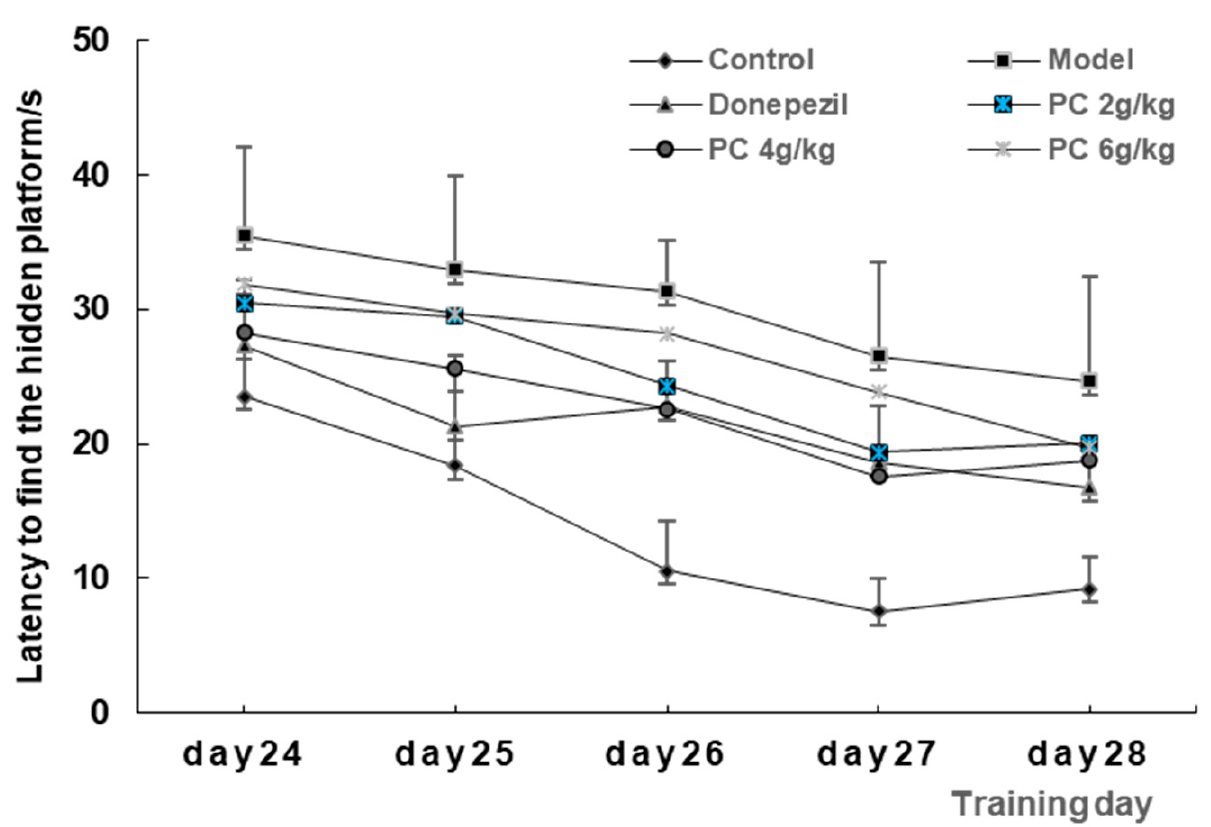
Figure 3. The latencies of mice in the acquisition trials of MWM. A total of 60 mice were randomly divided into six groups of 10 animals each, the control (0.5% CMC-Na solution, 0.2 ml/10 g), the model (0.5% CMC-Na solution, 0.2 mL/10 g), donepezil (3 mg/kg), and PC low- (2 g/kg), medium- (4 g/kg), and high- (6 g/kg) dose groups. All the groups were administered daily i.g. for 28 consec- utive days. The acquisition trials lasted 5 days, day 24-day 28. The data represents the mean ± SD.